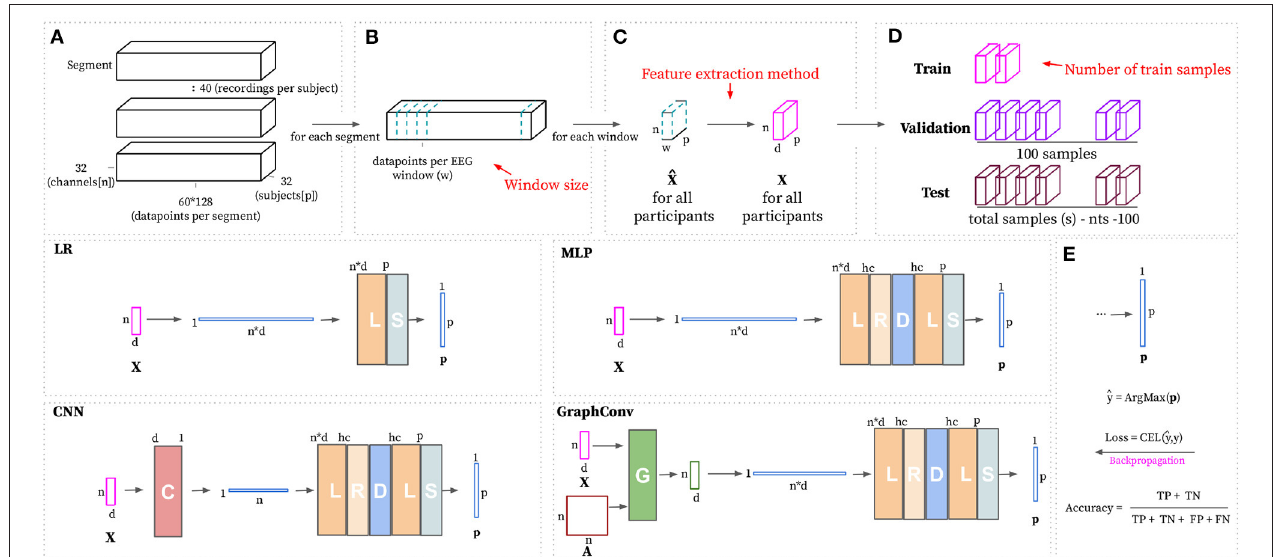
FIGURE 2 | The top part of this figure shows the hyperparameters (in red) that can be modified to build the train, validation, and test datasets starting from the pre-processed segments. (A) Complete dataset visualized as segments. There exists one segment per video. The shape of each segment is defined based on the total number of channels ( n ), the number of subjects( p ), and the total number of data points per video with baseline removed (60 s at 128 Hz). Panel (B) shows how the EEG windows are formed based on the window size ( w ). (C) Transforms pre-processed windows ˆ X using the feature extraction method that is set as hyperparameter. (D) Randomly samples tr s , 100 and total samples(s) - tr s - 100 for train, validation and testing, respectively, per participant. The bottom part of this figure shows the considered learning approaches, with non-linear approaches having a hc hyperparameter for deciding the number of hidden channels. (E) Subject ID prediction ˆ y is calculated by choosing the index of the maximum value in the predicted probability vector p . Training loss is computed using CELF (Equation 5). Evaluation is calculated as the number of correct predictions divided by the total number of